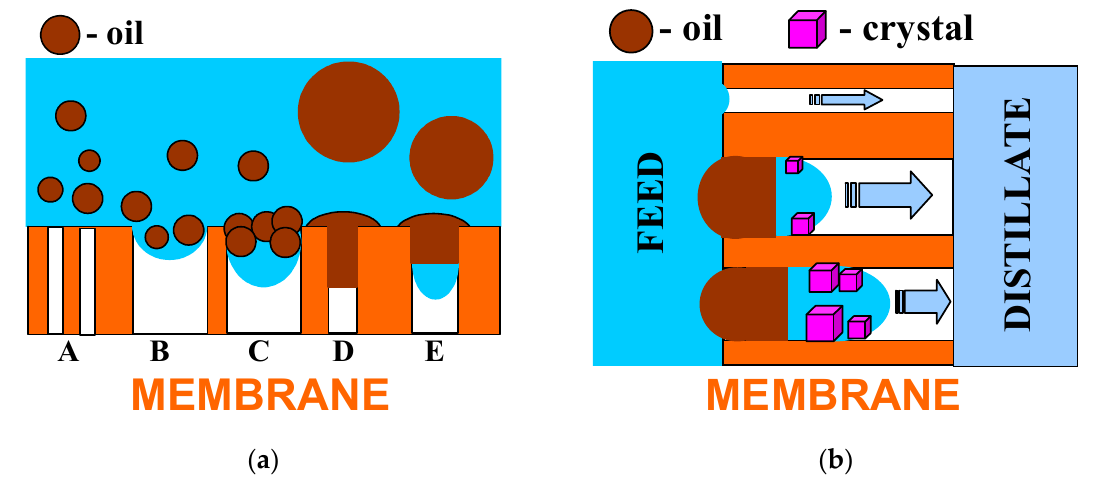
Figure 14. Model of hydrophobic membrane wetting during the MD process of brine contaminated with oil. ( a ) Influence of pore size and oil droplet’s diameter; ( b ) effects of internal scaling.